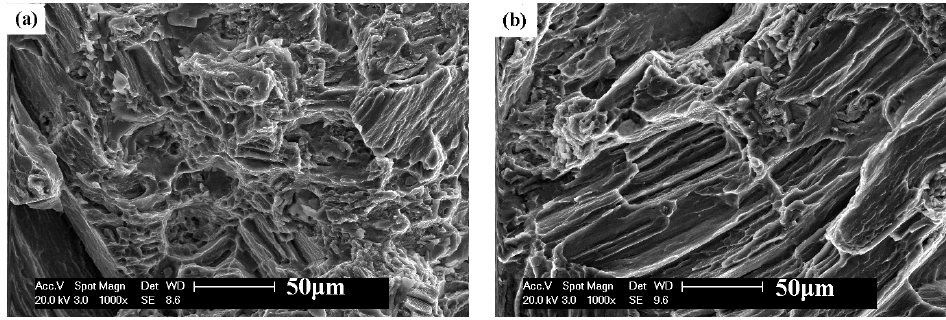
Table 1. Mechanical properties and stress corrosion cracking (SCC) indices for the studied alloys.